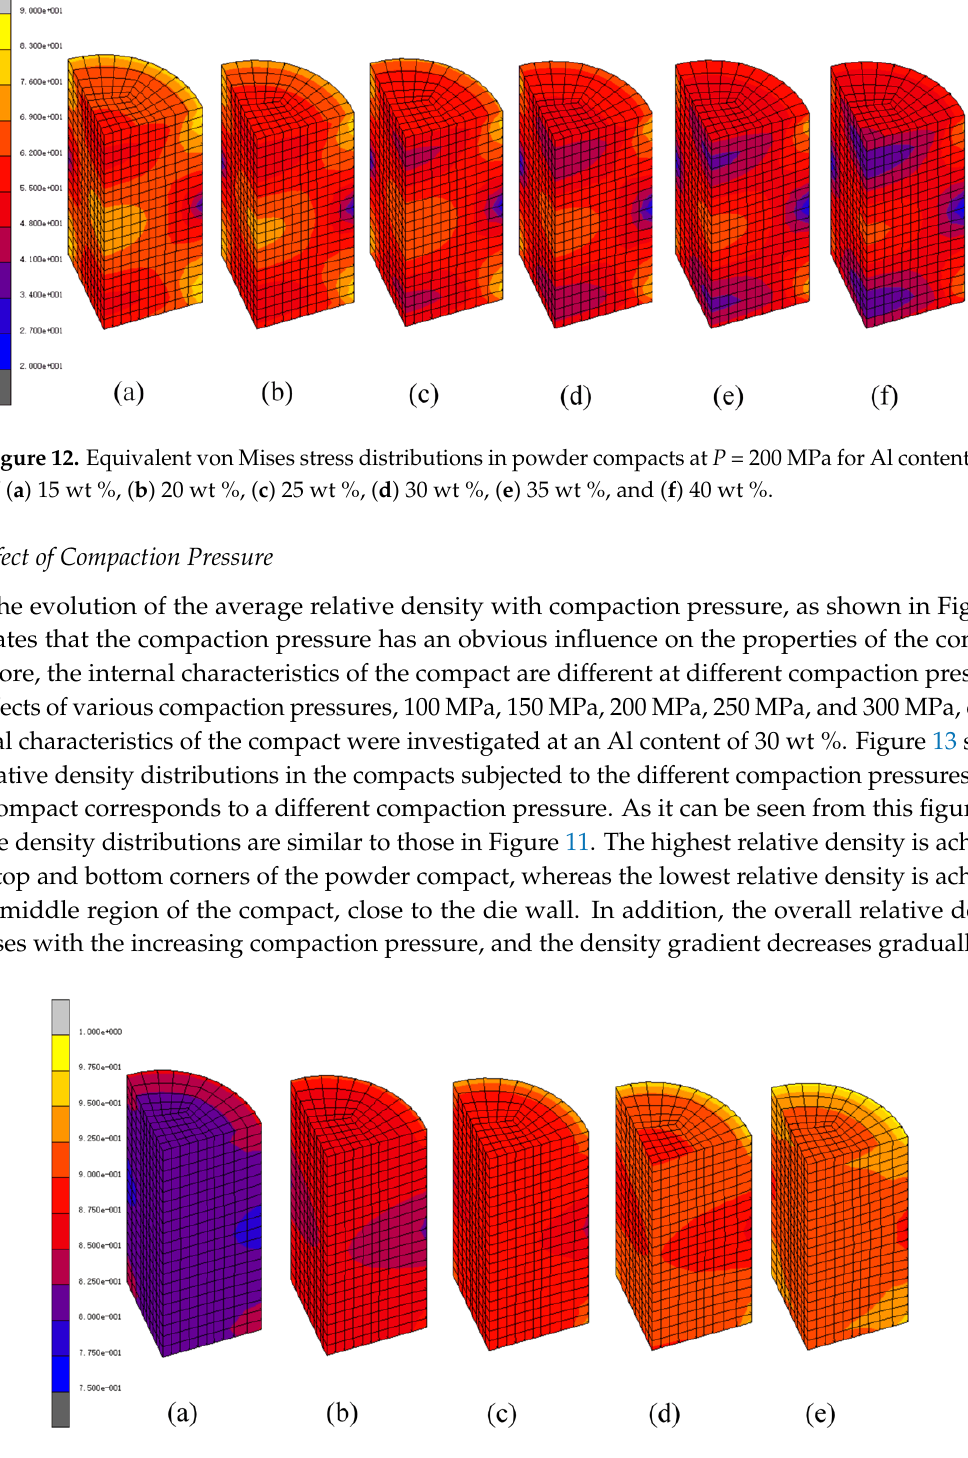
Figure 13. Relative density distributions in the powder compacts with an Al content of 30 wt % at compaction pressures, P , of ( a ) 100 MPa, ( b ) 150 MPa, ( c ) 200 MPa, ( d ) 250 MPa, and ( e ) 300 MPa.